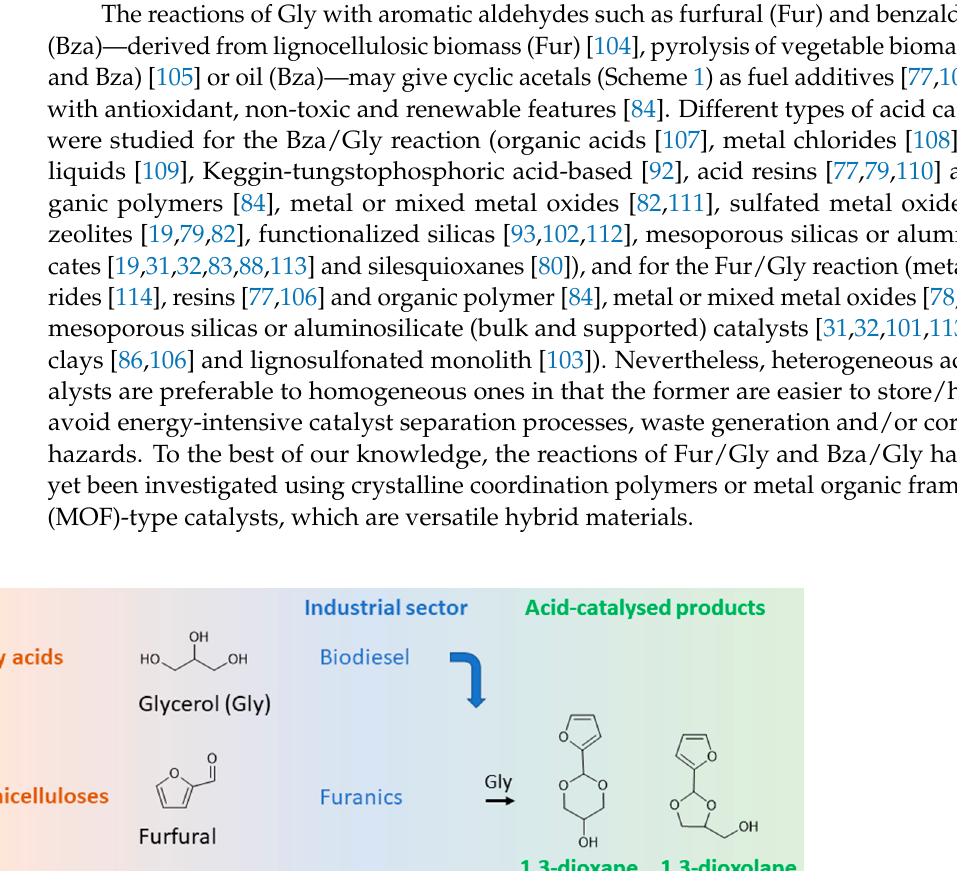
Figure 1. Structural representation of the positively charged crystalline coordination polymer [Gd(H 4 nmp)(H 2 O) 2 ]Cl·2H 2 O ( 1 ). 2. Results and Discussion 2.1. General Considerations The scaled-up synthesis of the hybrid material 1 (Figure 1) was successfully accom- plished, as confirmed by powder X-ray diffraction, which was similar to that reported in the literature (Supplementary Figure S1) [117]. Additional characterization studies are dis- cussed in the catalyst stability Section 2.5. Material 1 was explored as an acid catalyst for the reactions of Bza (Section 2.2) and Fur (Section 2.3) with Gly, to give heterobicyclic products. The interest in the repurposing/valorization of Fur, Bza and Gly is related to the